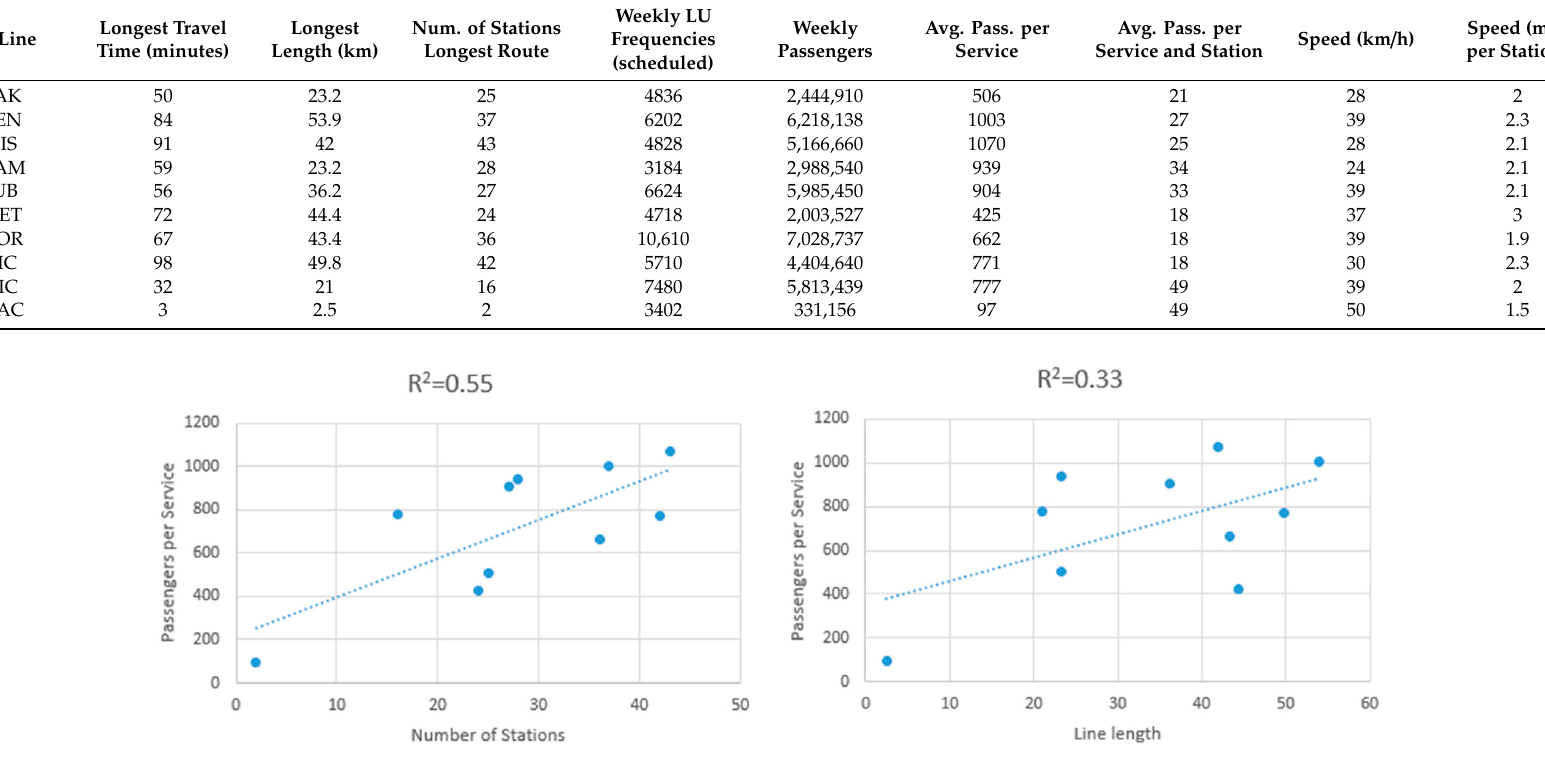
Figure 10. LU Daily passengers per Line. Figure 11 presents the distribution of passengers per day of week and time bands (Early 3–7, AM Peak 7–10, Midday 10–16, PM peak 16–19, Evening 19–22, Late 22–3). AM and PM peak hours (3 h each) concentrate most of the use from Monday to Friday, whereas Midday (6 h) is the preferred time band for weekend passengers. WAC (Waterloo & City) only operates from Monday to Saturday and has the highest use during Monday to Friday peak hours. Late traffic is higher on Saturday and also Friday, which motivates the different traffic pattern of Friday versus Monday to Thursday, and the higher number of passengers of Friday than Monday to Thursday (except MET and WAC lines, see Figure 10).